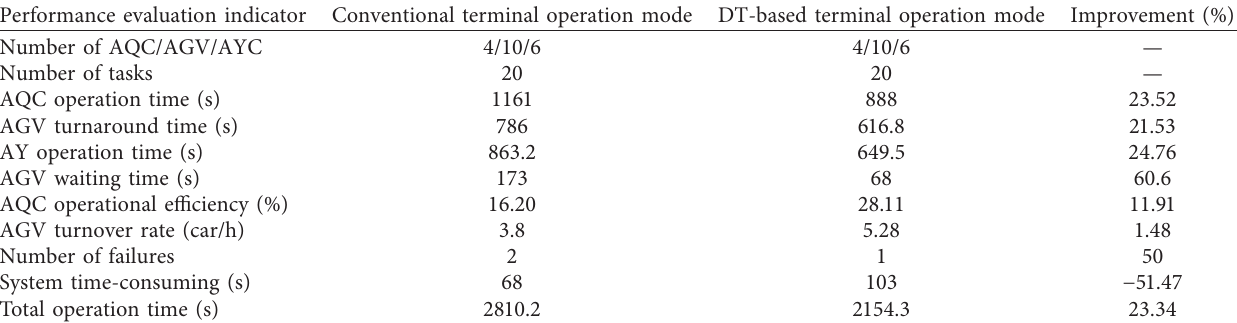
Table 3: Test results of conventional and DT-based operations for small-scale problems.